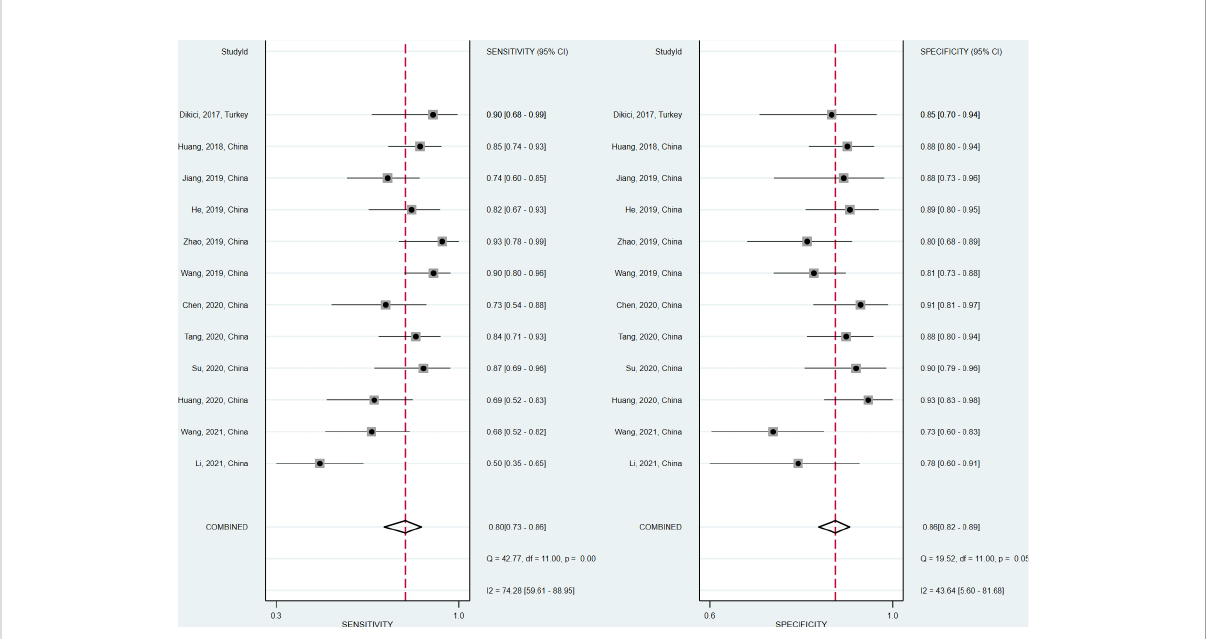
FIGURE 2 Coupled forest plots of the sensitivity and speci fi city of tibial nerve stiffness measurement by Supersonic Shear Wave Imaging (SSI) for diagnosing diabetic peripheral neuropathy (DPN).